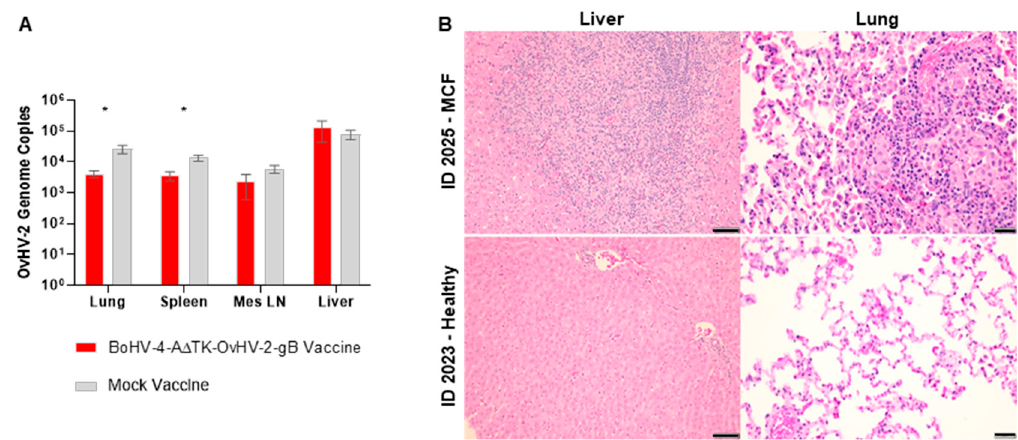
Figure 4. Development of MCF following immunization with BoHV-4-A ∆ TK-OvHV-2-gB and challenge with OvHV-2 in a rabbit model. ( A ) OvHV-2 genome copies in tissues of BoHV-4-A ∆ TK-OvHV-2-gB and mock immunized rabbits. Results are mean OvHV-2 genome copies per 50 ng of total tissue DNA quantified by OvHV-2 qPCR and error bars represent SEM. *, indicates a p < 0.05 as tested by Mann–Whitney test. ( B ) Representative histological images of liver and lung of BoHV-4-A ∆ TK-OvHV-2-gB vaccinated rabbits that developed MCF (ID 3025) or remained healthy (ID 3023) following OvHV-2 challenge. Rabbit ID 3025: liver, moderate portal and periportal hepatitis with portal bridging (bar: 50 μ m); lung, mild focal pneumonia with a predominance of macrophages and small lymphocytes (bar: 20 μ m). Rabbit ID 3023: unre- markable liver (bar: 50 μ m); unremarkable lung (bar: 20 μ m).